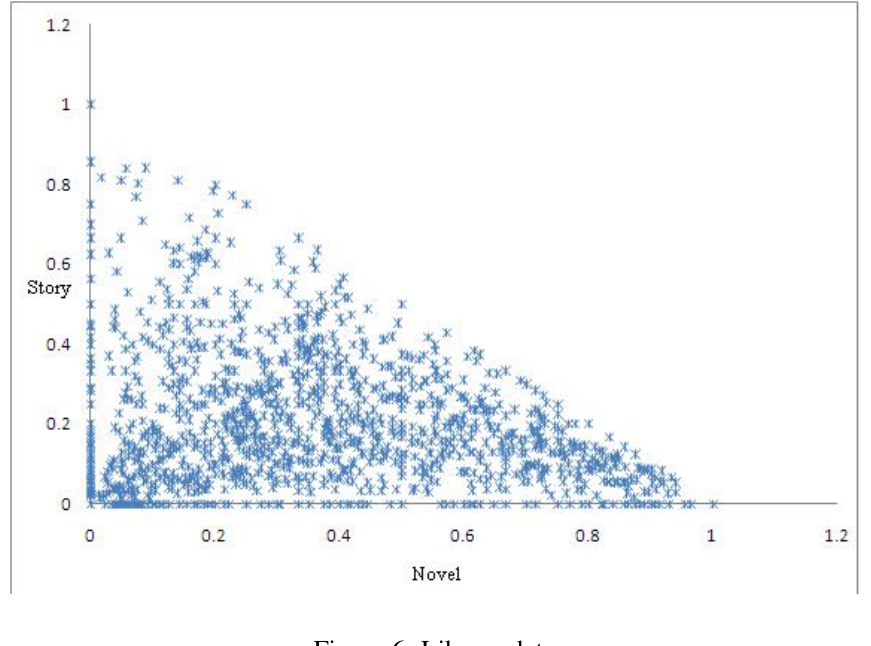
Figure 6: Library data